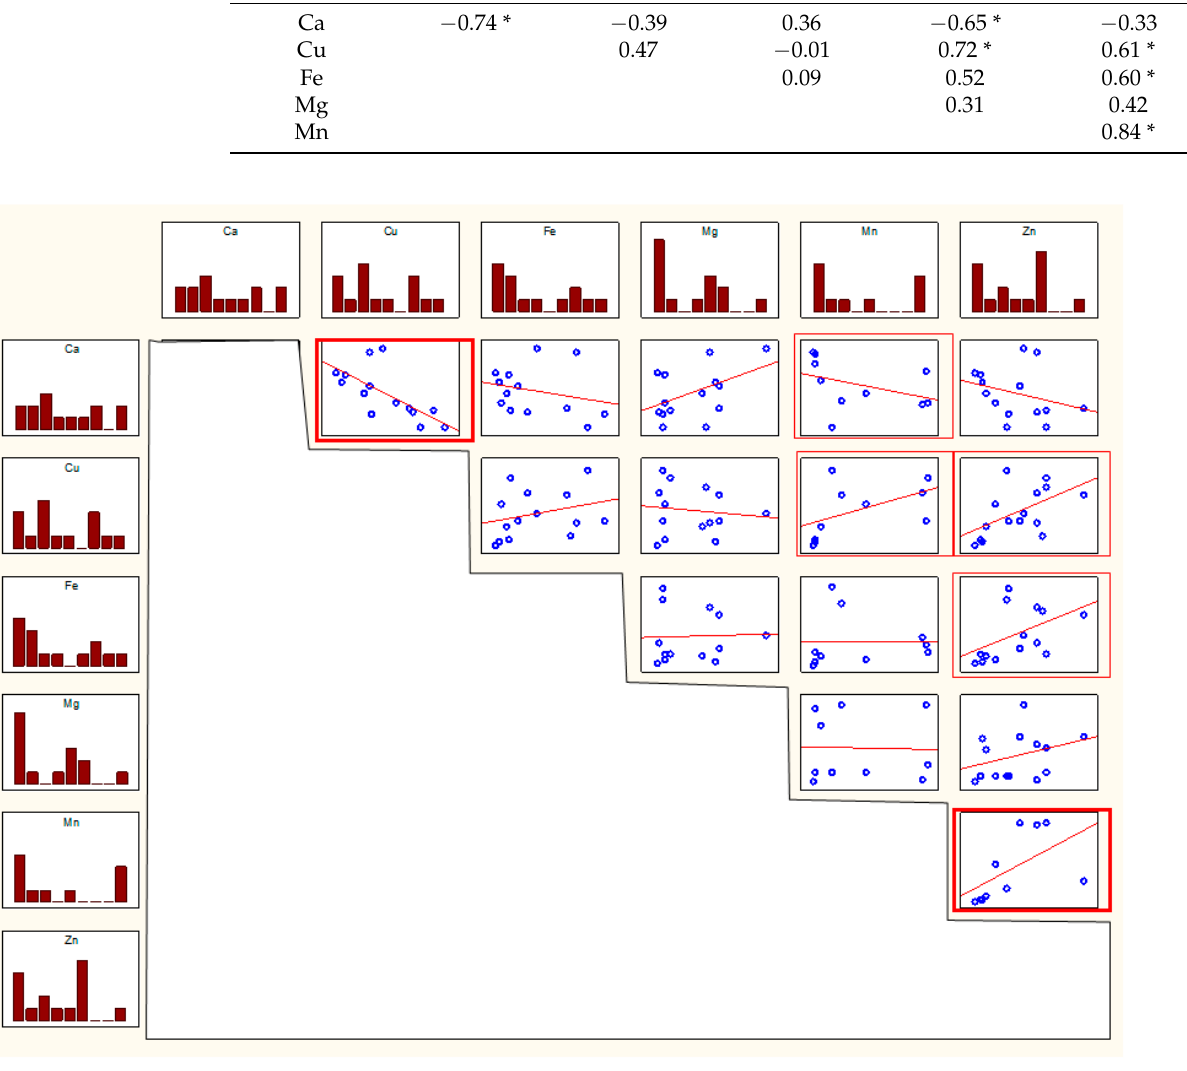
Figure 3. Scatterplot for pairs of elemental parameters in men. Thick frame— p < 0.01, thin frame— p < 0.05. Table 1. The values of the correlation coefficients for the content of analytes in the tissue of men. Statistically significant values are marked with an asterisk.